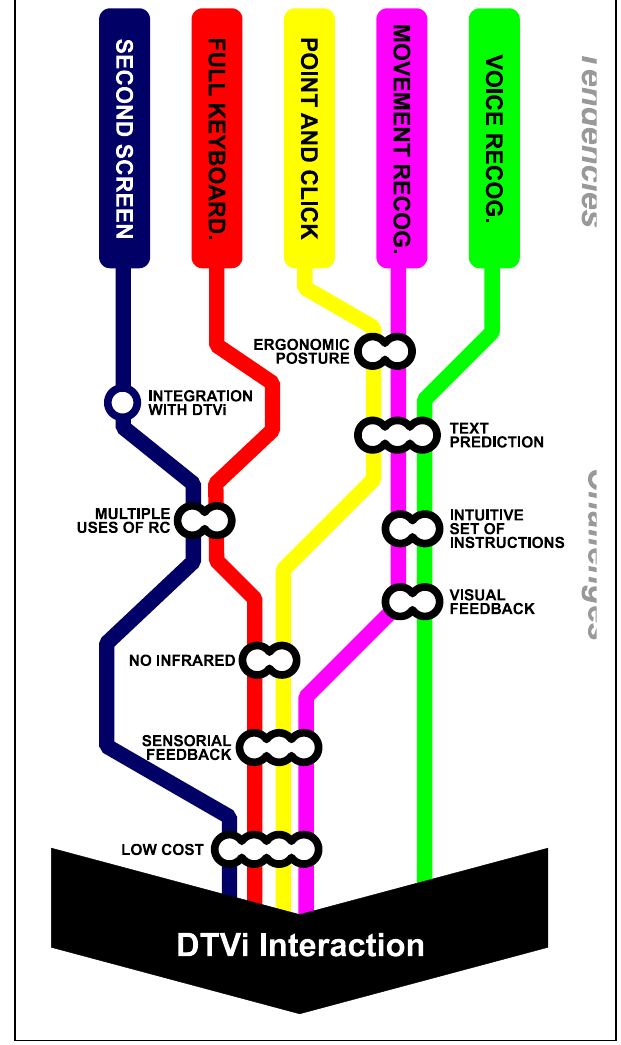
Fig. 11 – Tendencies and challenges to interact with